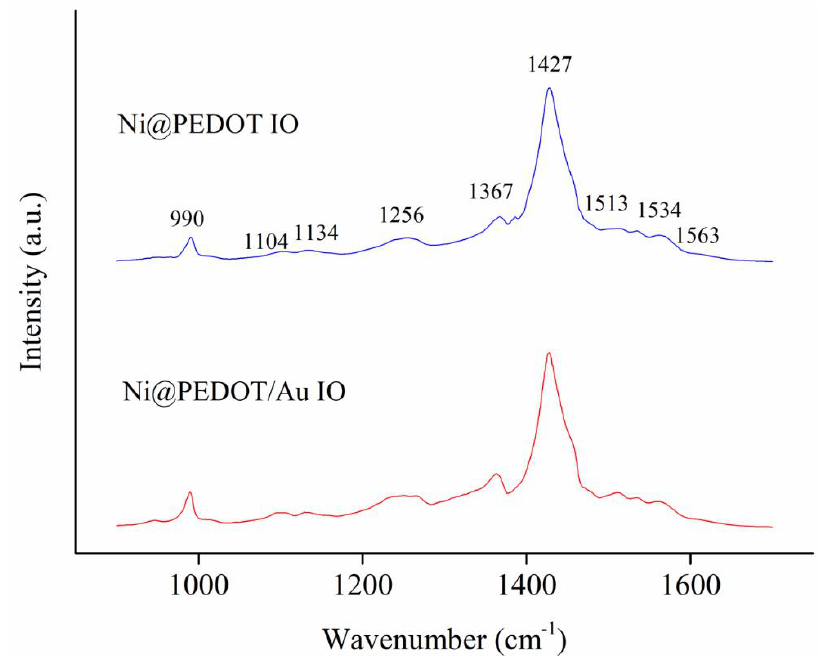
Figure 5. The Raman spectra for Ni@PEDOT and Ni@PEDOT/Au inverse opals, respectively. Table 1. The vibration modes of PEDOT in the Raman spectra [46,47,51].